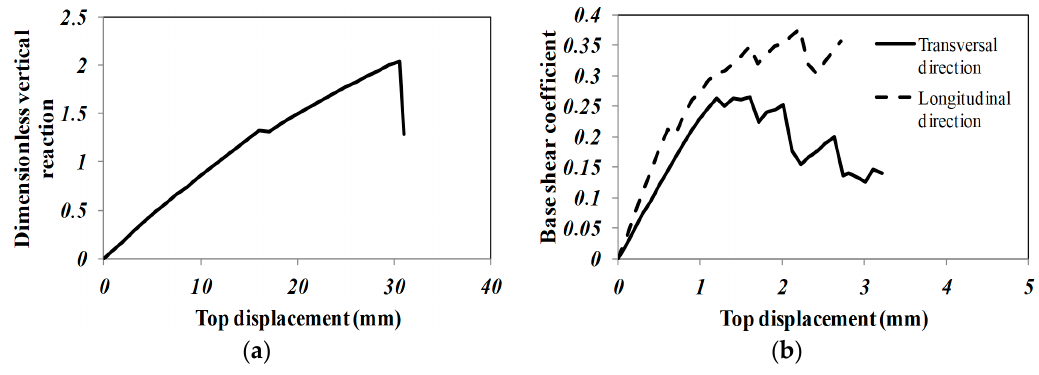
Figure 19. Capacity: ( a ) vertical; and ( b ) horizontal directions.